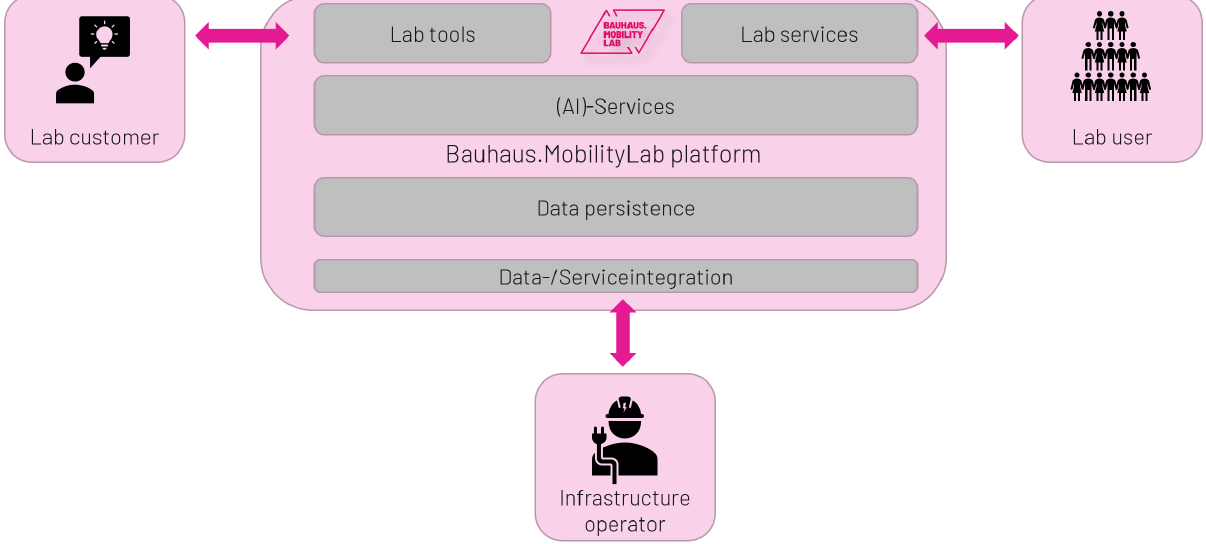
Figure 1. High-level platform